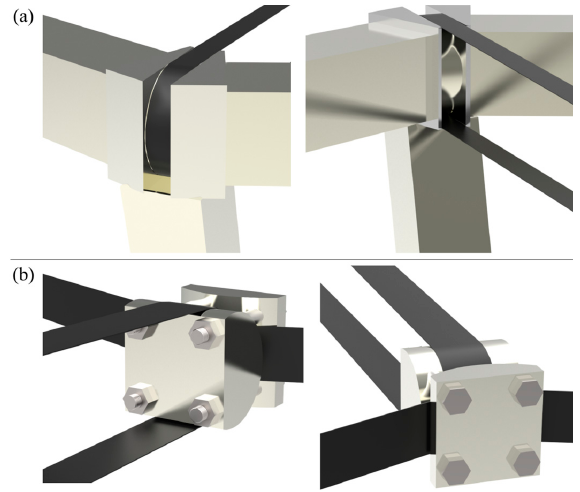
Figure 30. ( a ) Node at outer compression ring and ( b ) node at inner tension ring.